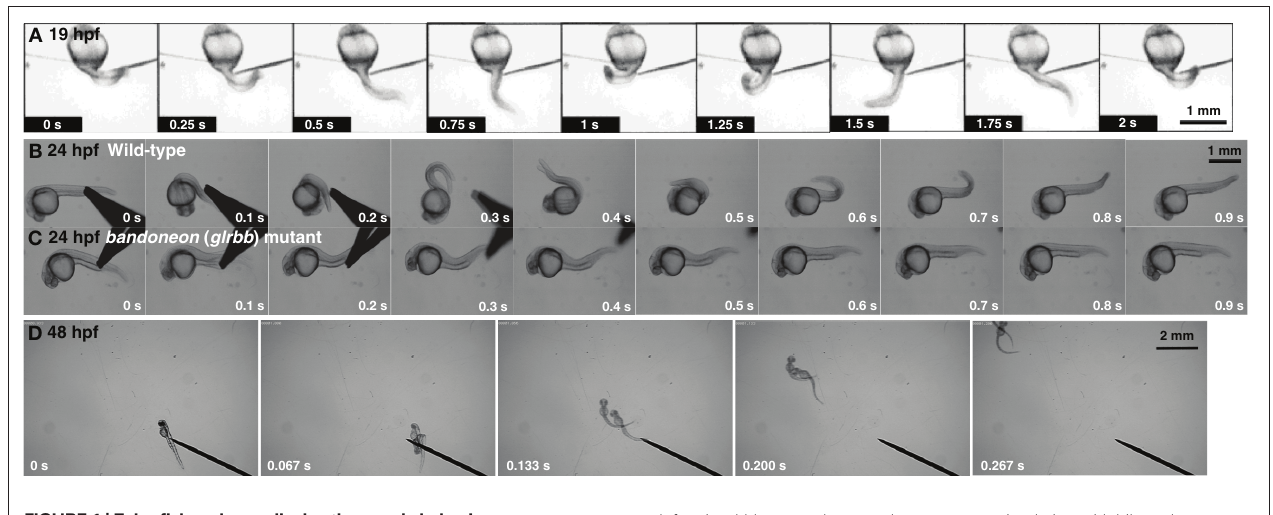
defect in glrbb responds to mechanosensory stimulation with bilateral axial muscle contractions that causes the trunk to shorten and bend dorsally. (D) At 48 hpf, wild-type embryos swim away following tactile